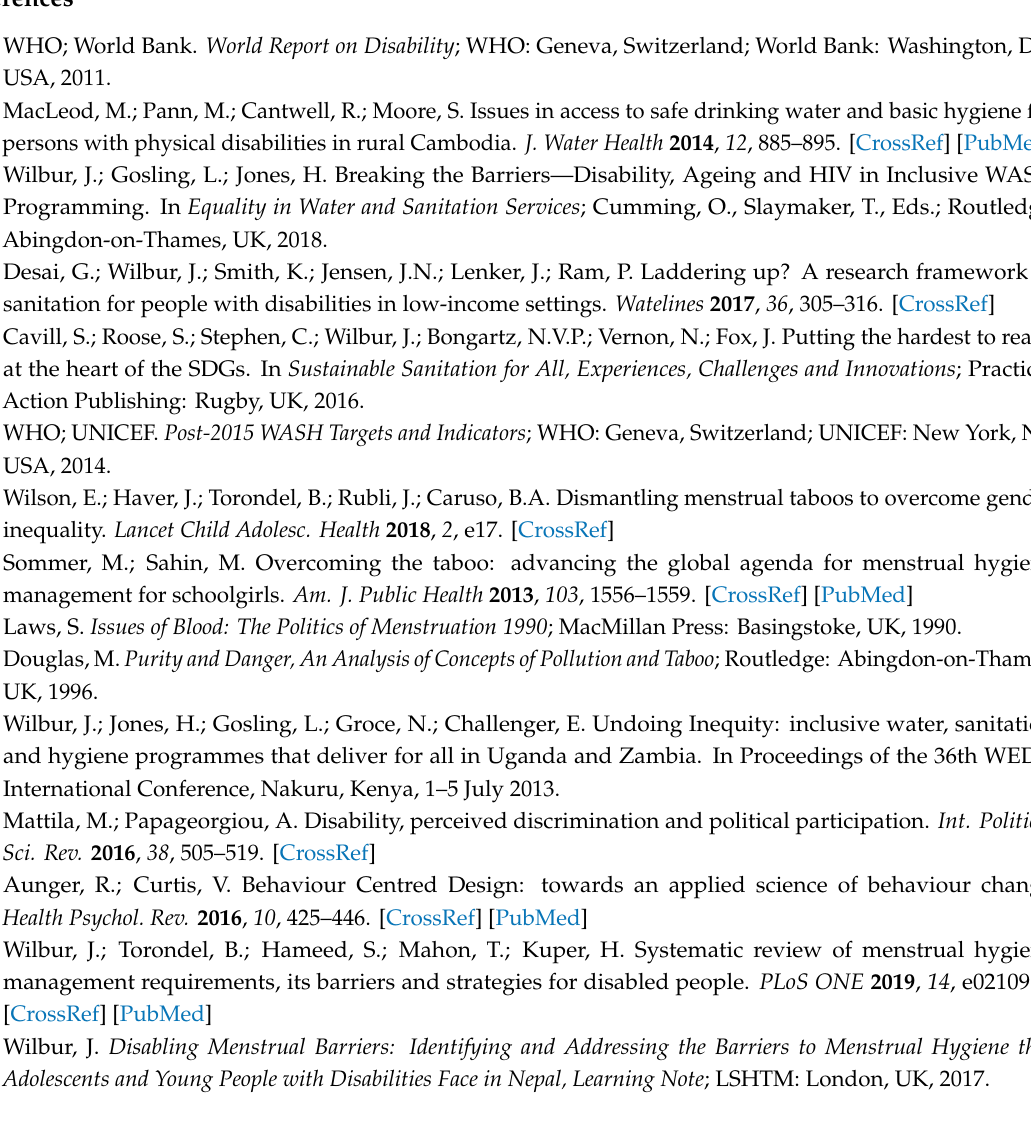
Table S1: Feasibility study indicators and results, Table S2: Structured questionnaire results and analyses of the findings against the qualitative data. The Bishesta campaign will be available for free download from December 2019 at https: // washmatters.wateraid.org /